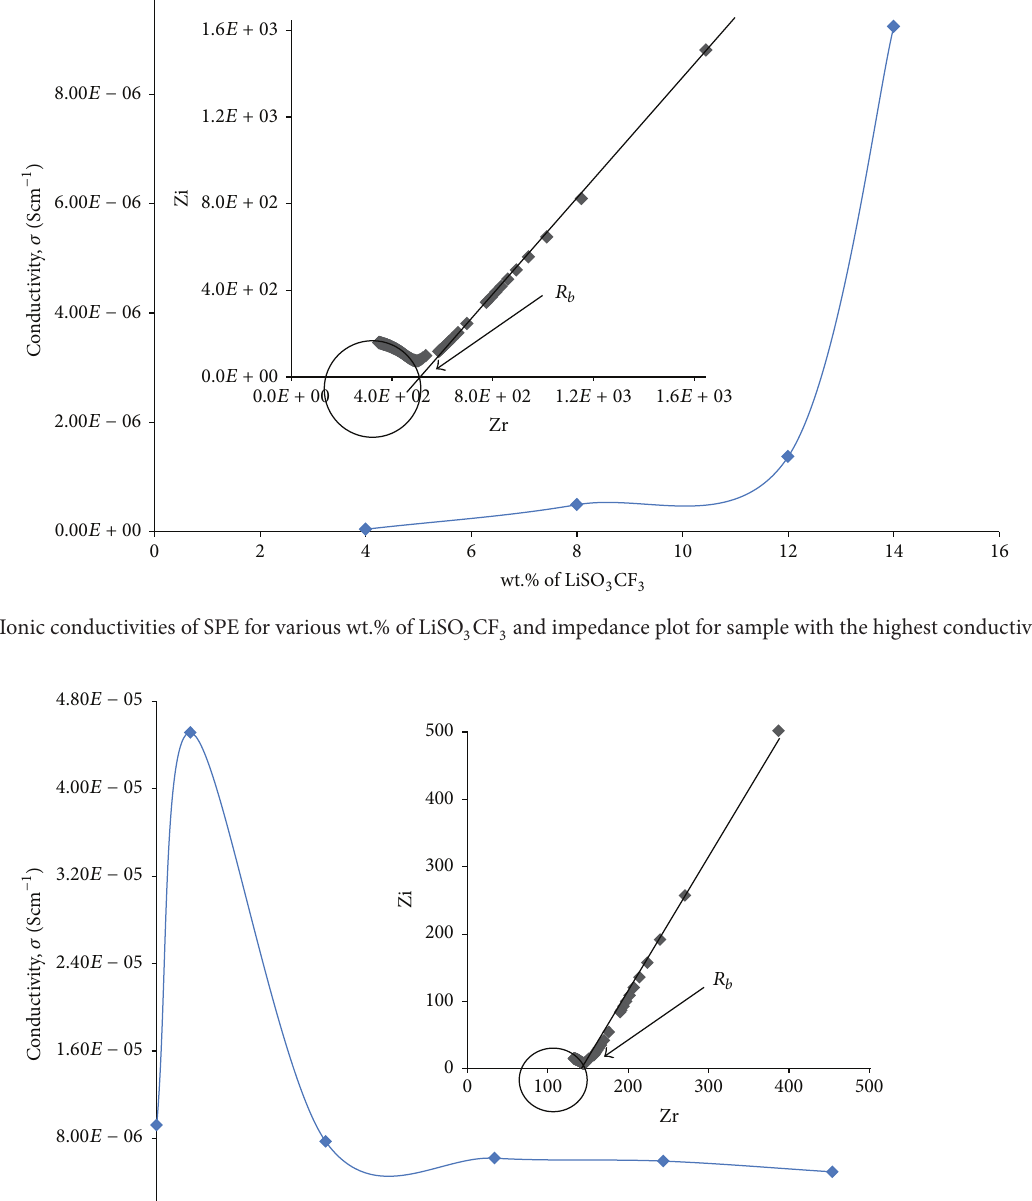
LiCF 3 SO 3 + 1 wt.% DBP + 0.05 wt.% ZrO 2 . However,